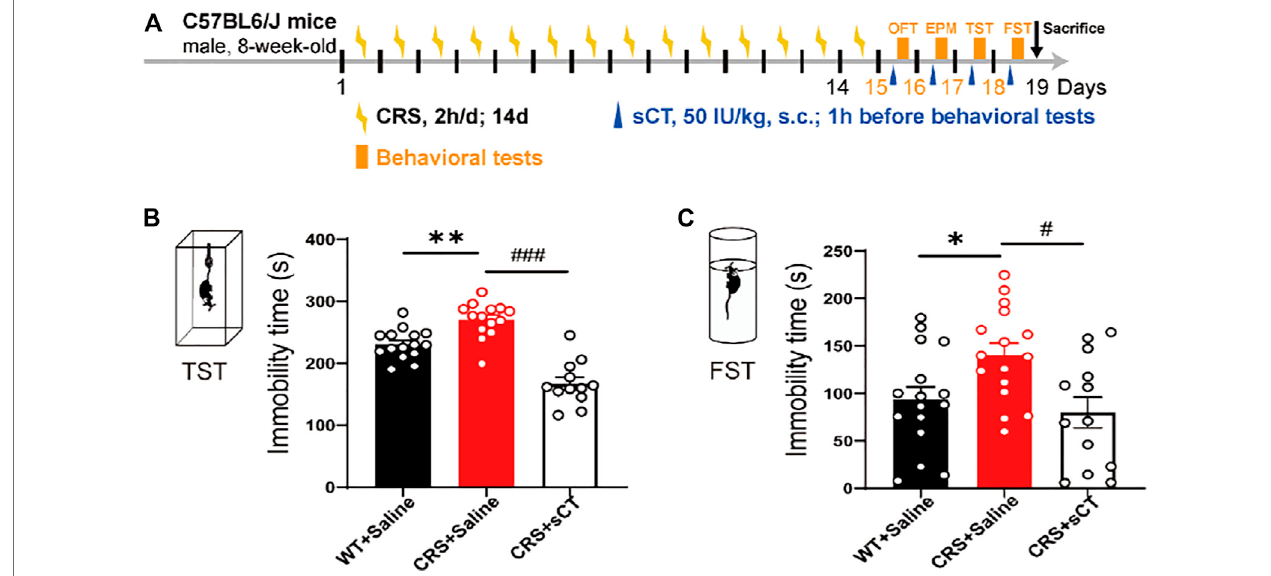
FIGURE 5 | sCT exerted an antidepressant effect in CRS mice. Schematic illustration of the experimental design (A) . In TST, the immobility time of CRS mice was increased, while sCT could decrease the immobility time of CRS mice (WT + saline: n = 15; CRS + saline: n = 14; CRS + sCT: n = 12) (B) . In FST, the immobility time of CRSmicewasincreased,whilesCTshortenedimmobilitytimeinCRSmice(WT+saline: n =16;CRS+saline: n =16;CRS+sCT: n =13) (C) .Thedatawereanalyzedby one-way ANOVA with Tukey ’ s multiple-comparisons test. *p < 0.05, **p < 0.01 vs. WT + saline; # p < 0.05, ### p < 0.001 vs. CRS + saline. sCT, salmon calcitonin; CRS, chronic restraint stress; TST, tail suspension test; FST, forced swimming